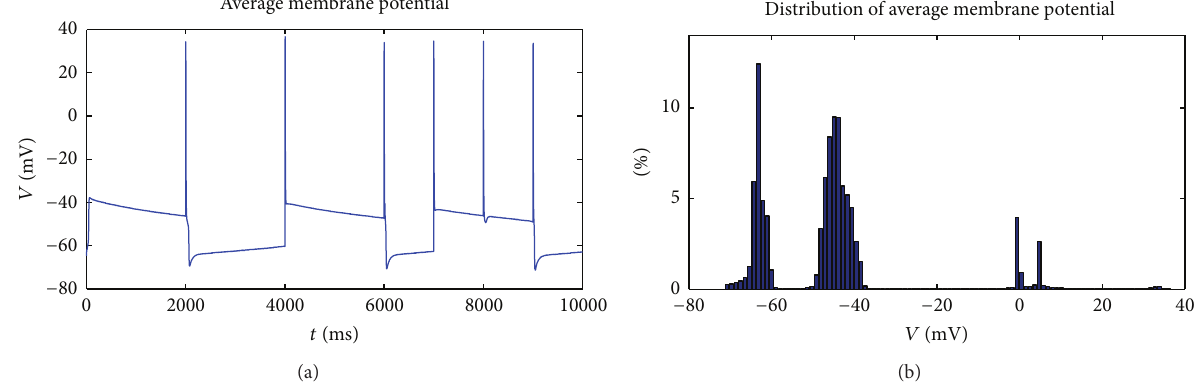
Figure 9: Adding stimuli on each neuron of the spontaneous model to rapidly increase the sodium conductance.